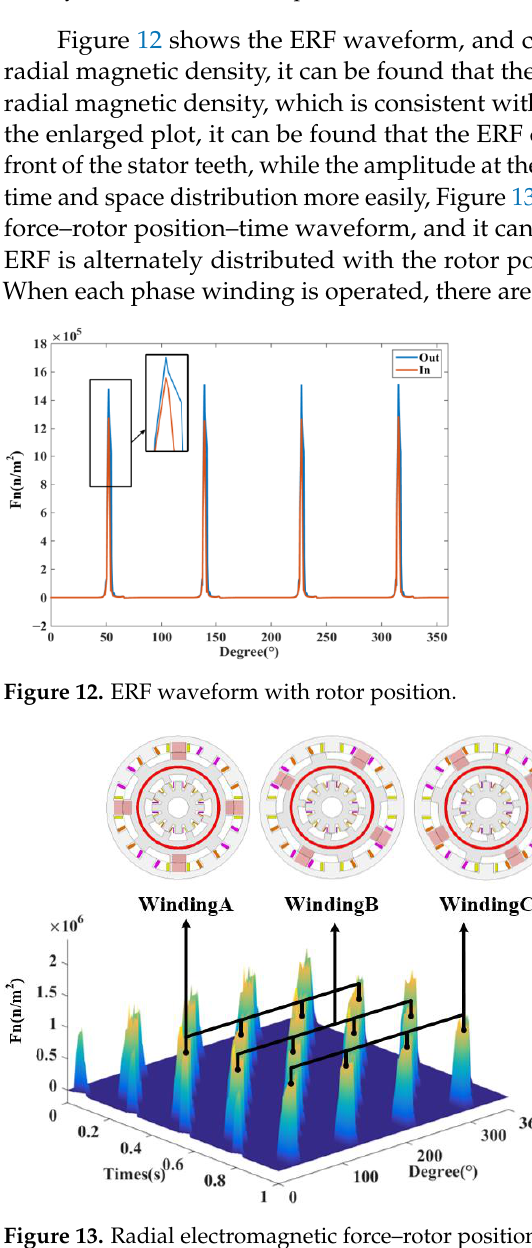
Figure 11. Radial magnetic density of air-gap time inside and outside the DDSRG. ( a ) Magnetic density. ( b ) Harmonic decomposition.